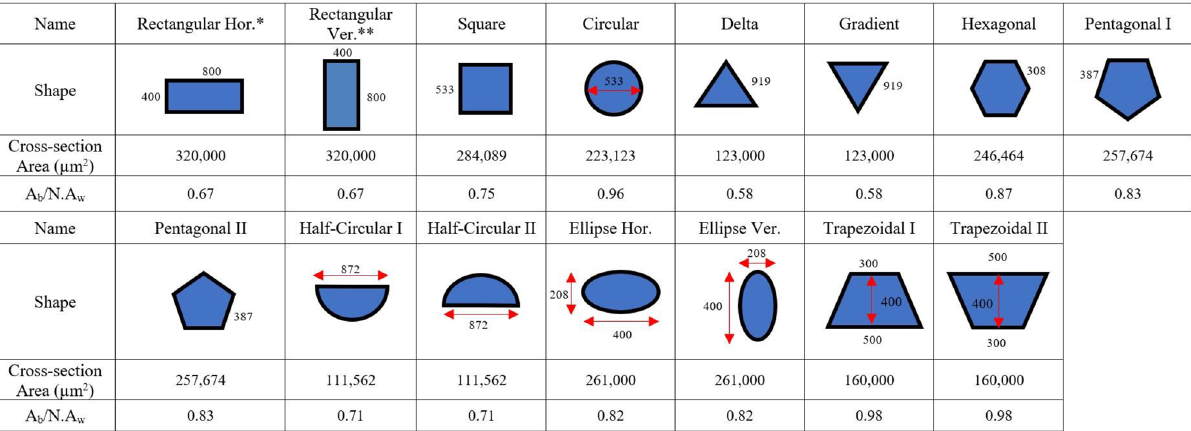
Table 2. Different microchannel cross-sections with hydraulic diameters of 533 µm. *Hor., Horizontal. **Ver., Vertical (all dimensions are in